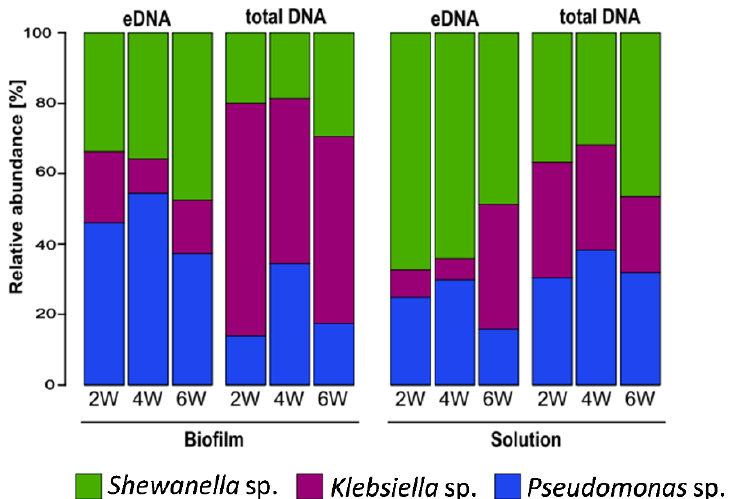
Figure 7. Mean relative abundance of biofilm and planktonic microbial taxa: eDNA: extracellular DNA. 2W: 2 weeks of exposure; 4W: 4 weeks of exposure; 6W: 6 weeks of exposure. Data are the average of two biological replicates.